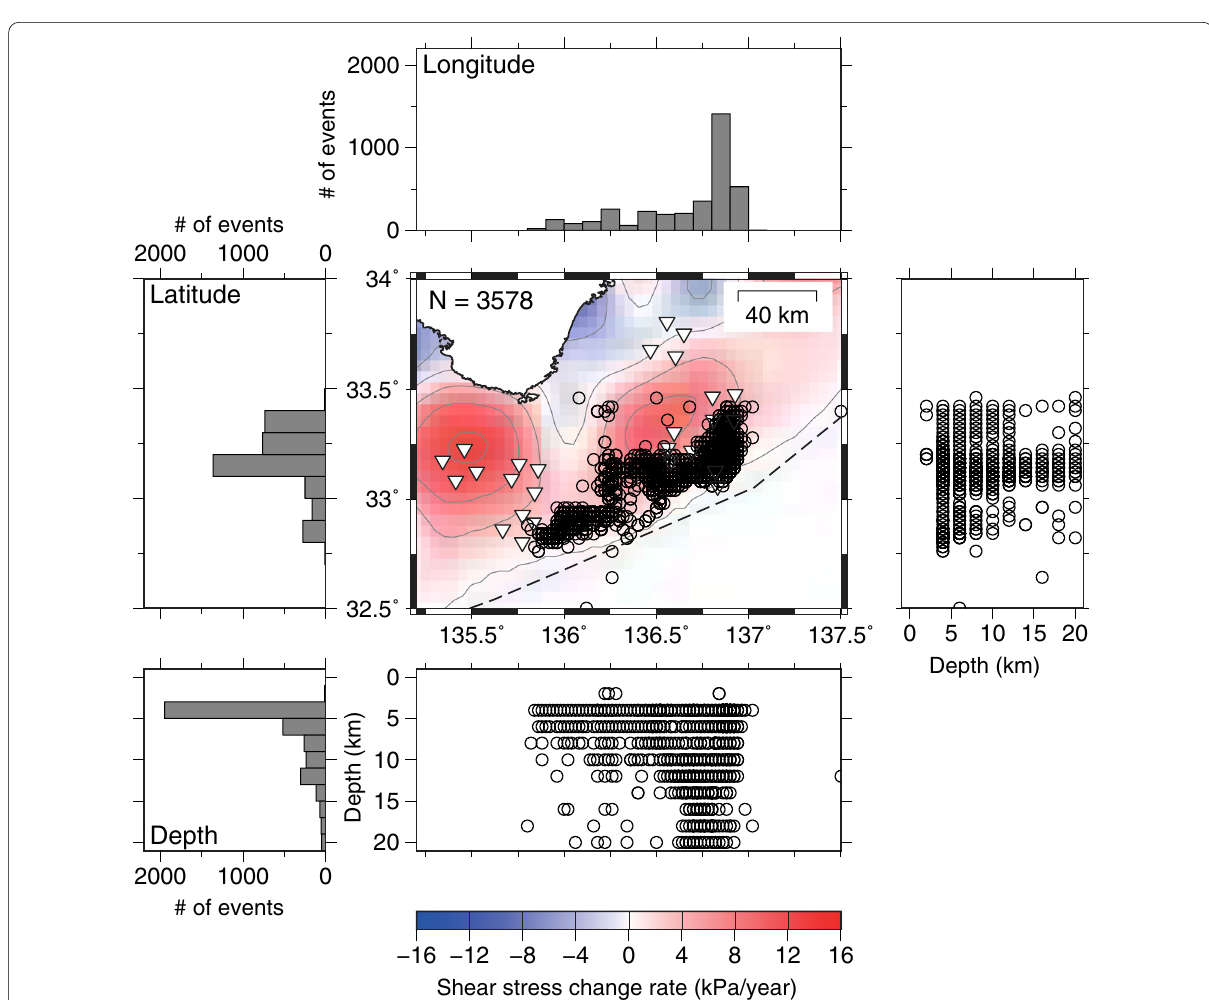
Fig. 3 Epicenters, vertical cross sections and the histograms of longitudinal, latitudinal, and depth distributions of tremor locations determined herein between 1 December 2020 and 31 January 2021. Circles are tremor locations, and inverted triangles are DONET stations. The longitudinal and latitudinal histograms have bin sizes of 0.1 ◦ , and the depth histogram has bin size of 2 km. Color contours describes the shear stress accumulation rate at the plate boundary estimated by Noda et al.